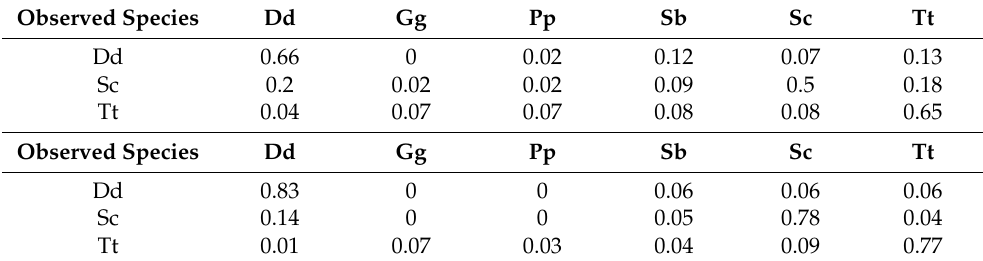
Table 4. Confusion matrix for all images ( top ) and the high-confidence selections ( bottom ). Observed Species Dd Gg